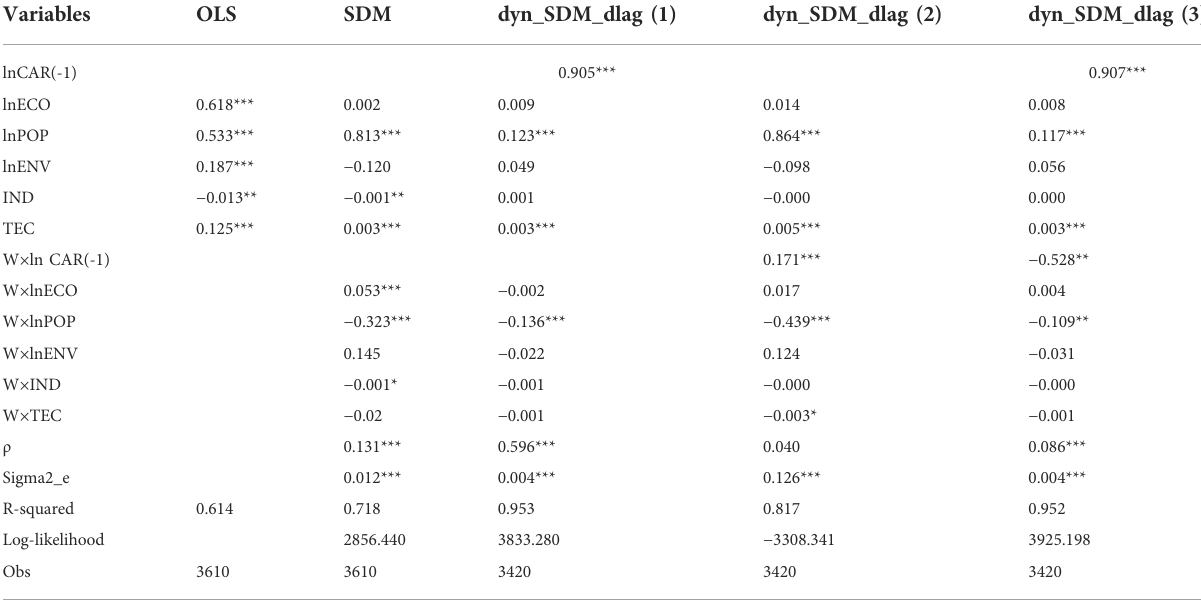
TABLE 3 Estimation results of OLS model and SDM model.